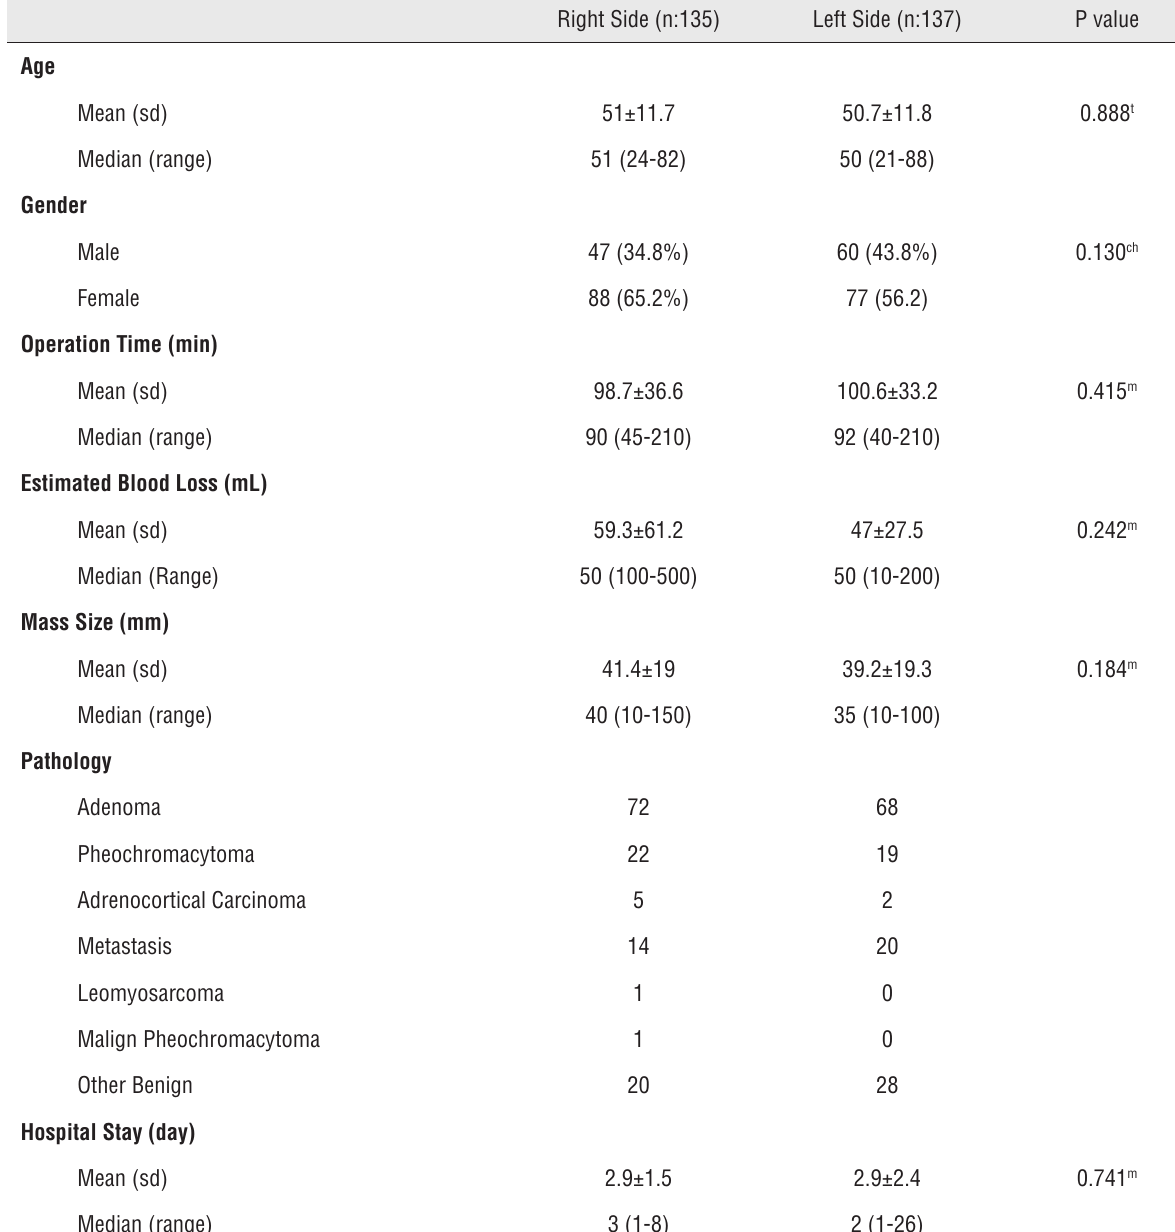
Table 1 - Comparison of right and left laparoscopic adrenalectomy cases. Right Side (n:135) Left Side